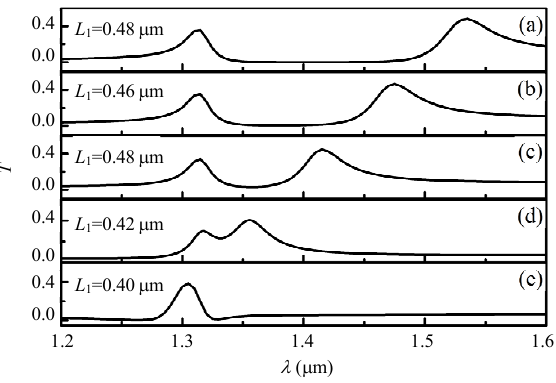
Fig. 5 Transmission spectra of the side-coupled resonator systems with (a)  (e): L 1 = 0.48 μ m, L 1 = 0.46 μ m, L 1 = 0.44 μ m, L 1 = 0.42 μ m, and L 1 = 0.4 μ m, respectively.